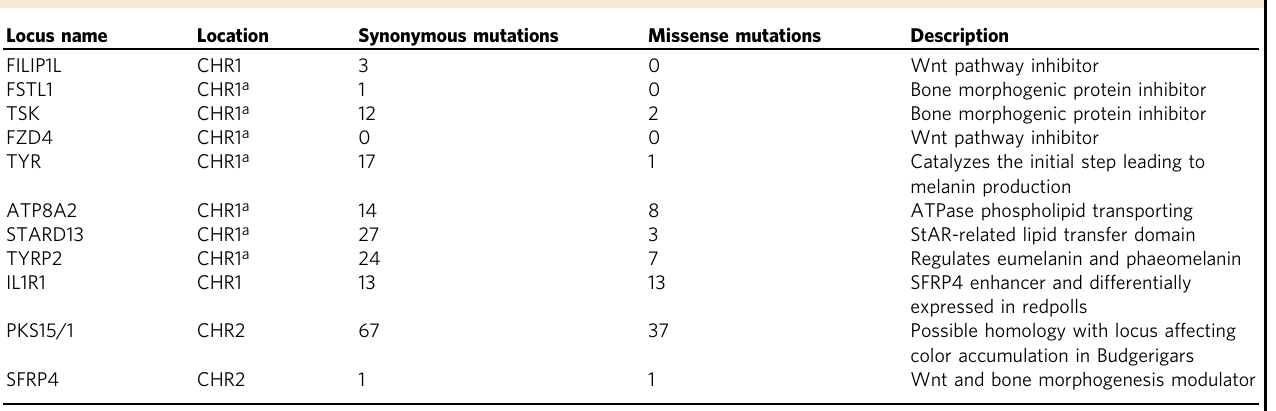
Fig. 3 Correlations between inversion genotype, morphology, and latitude. a Phenotype PC1 and gene expression data (as mds PC1) from Mason and Taylor (2015) colored by inversion genotype, with extreme phenotypes produced by homozygotes shown in gold and pink, and an intermediate phenotype produced by a heterozygote shown in green. b Latitude of sampling site for each individual grouped by inversion genotype demonstrating B haplotypes increase in frequency with latitude (AA n = 37, AB n = 7, BB n = 28). Box hinges represent the fi rst and third quartiles, with centers representing medians. Whiskers represent maximum and minimum values except for BB, where outliers are values exceeding 1.5 times the interquartile range. Source data are provided as Source data fi le. Table 1 Candidate genes for plumage color and bill